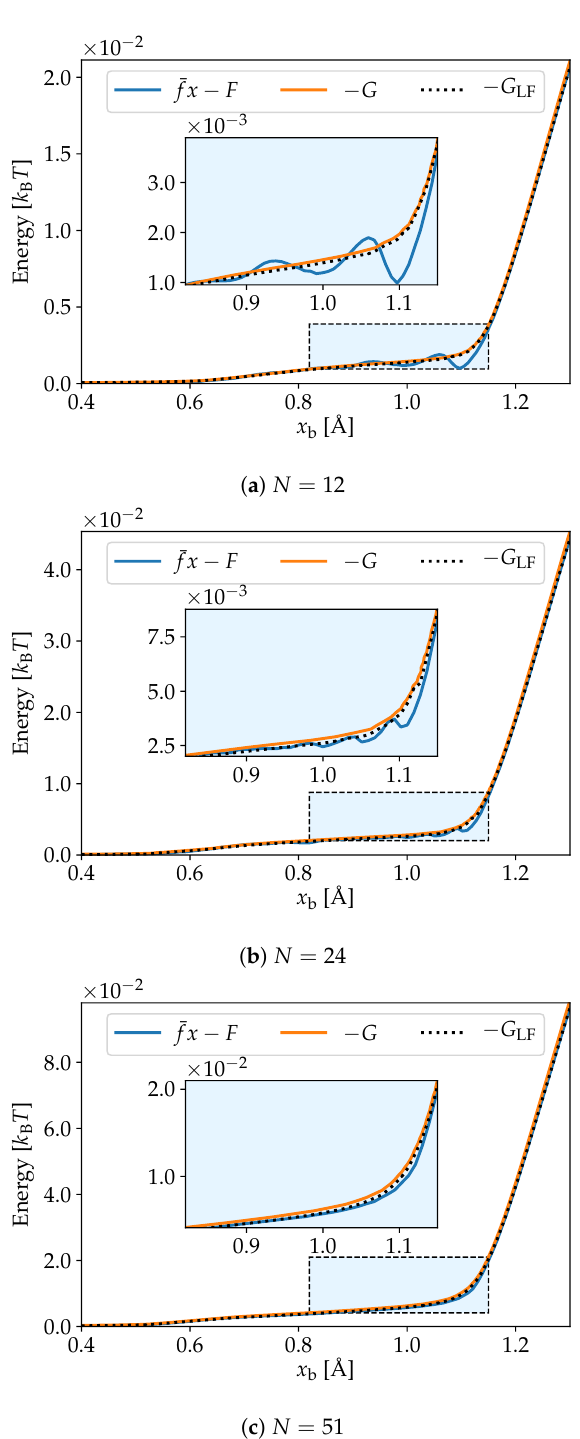
Figure 2. Energy as a function of length per bond for chains of PEO composed of N = 12, 24 and 51 united atoms. While the Legendre transform of the Helmholtz energy F is different from minus the Gibbs energy G , we see that the Legendre–Fenchel transform G LF is an excellent approximation in all three